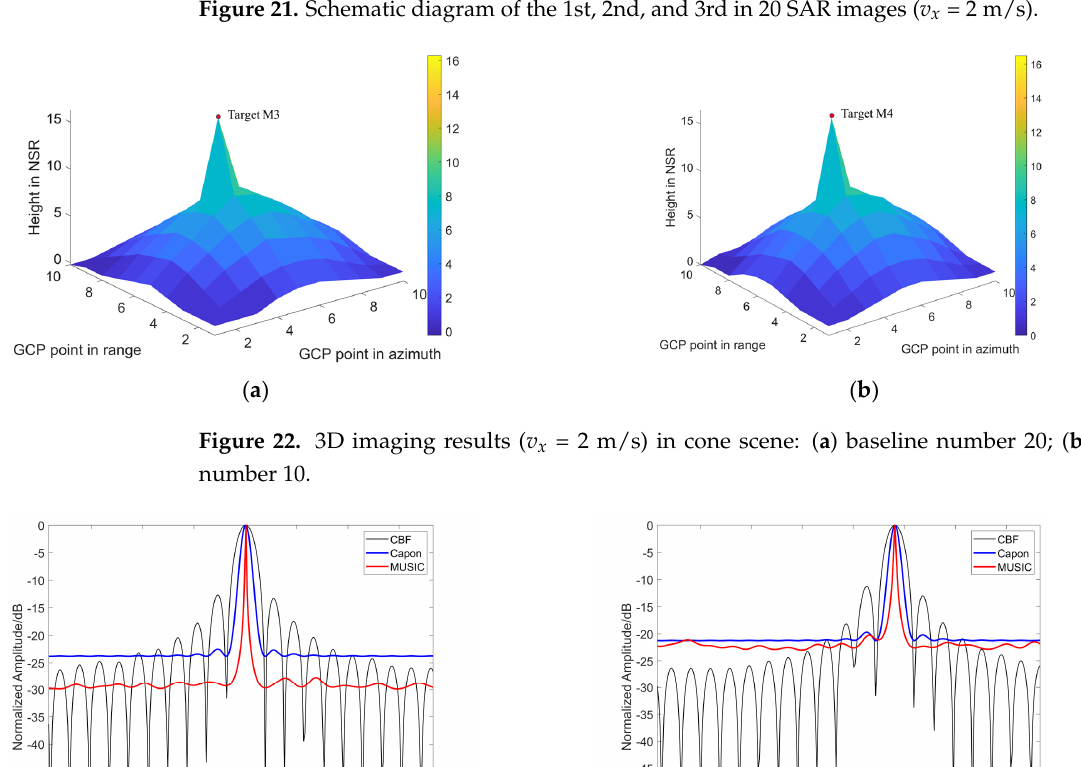
Figure 22. 3D imaging results ( v x = 2 m/s) in cone scene: ( a ) baseline number 20; ( b ) baseline num- ber 10.